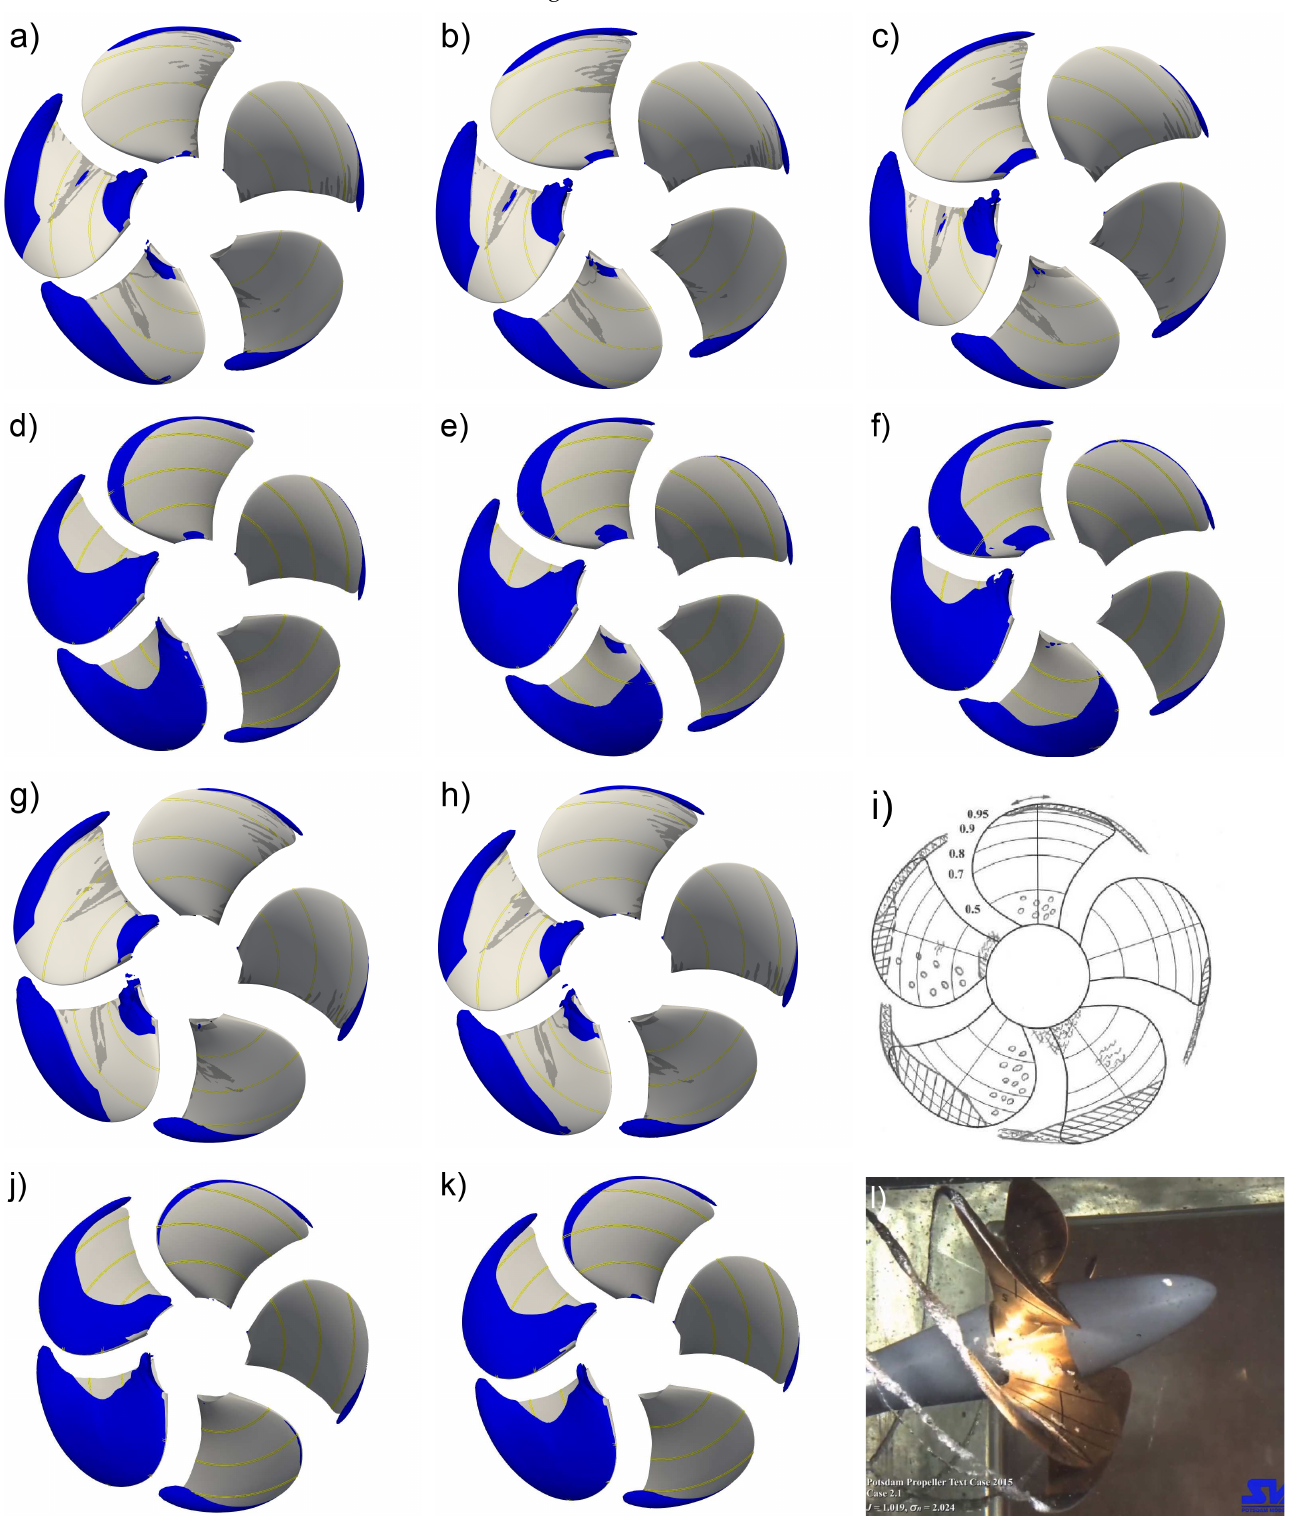
Figure 17. Predicted cavitation pattern ( α v = 0.5) using the bridged model (upper frames ( a – c , g , h )) and k − ω SST + SS without transition model (lower frames ( d – f , j , k )) compared to the experimental sketch ( i ) and photo snapshot ( l ). ( a , d ) blade phase = 12 ◦ ; ( b , e ): blade phase = 24 ◦ ; ( c , f ) blade phase = 36 ◦ ; ( g , j ) blade phase = 60 ◦ ; ( h , k ) blade phase = 0 ◦